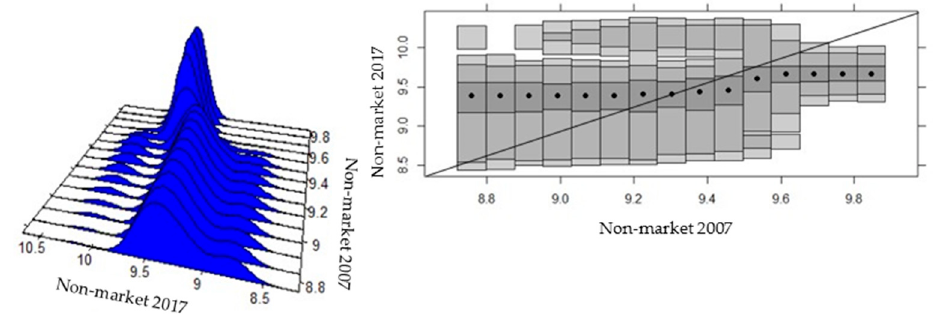
Figure 12. Intra-distribution dynamics of provincial productivity in the non-market service subsector, 2007–2017. Source: Own elaboration based on the Regional Accounts of the BCE [46]; ENEMDU surveys from the INEC [47] (several years) and stacked conditional density plot (SCD) in R.